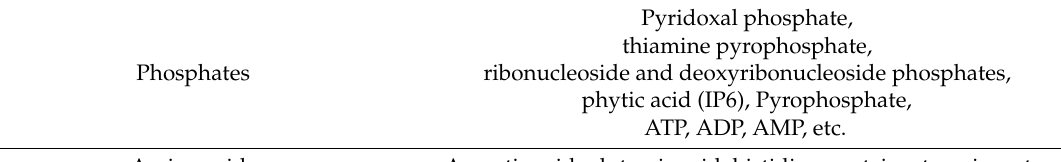
Table 2. Examples of naturally occurring low molecular weight chelators a ff ecting iron metabolism. Pyridoxal phosphate, thiamine pyrophosphate, ribonucleoside and deoxyribonucleoside phosphates, Phosphates phytic acid (IP6), Pyrophosphate, ATP, ADP, AMP, etc. Amino acids Aspartic acid, glutamic acid, histidine, cysteine, tyrosine, etc. Carboxylic acids Citric acid, aconitic acid, oxaloacetic acid, etc. Mono- and di- saccharides Fructose, glucose, lactose, etc. Vitamins Ascorbic acid, lipoic acid, riboflavin. Fatty acids and phosphoglycerides Oleic acid, linoleic acid, phosphatidic acid. Catecholamines, pteridines, purines, spermine, spermidine. Other naturally occurring chelators Glutathione. Folic acid. In addition to food components containing the above molecules, there are also many plant products including most polyphenols Dietary molecules and other phytochelators with iron chelating properties such as: catechin, maltol,